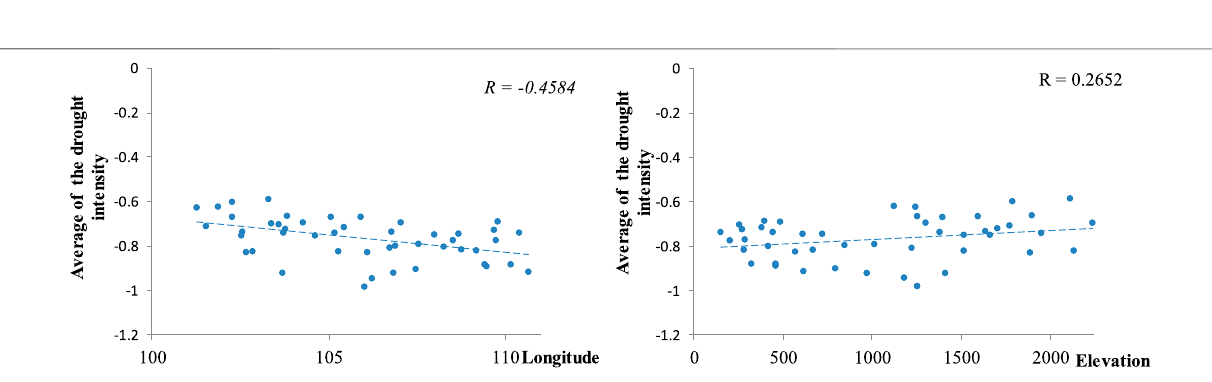
FIGURE11| Correlationbetweenaveragedroughtseverityandelevationandlongitude.Rrepresentsthecorrelationcoef fi cient,andtheboldfontsindicatethatthe con fi dence level is α (cid:1) 0.001.